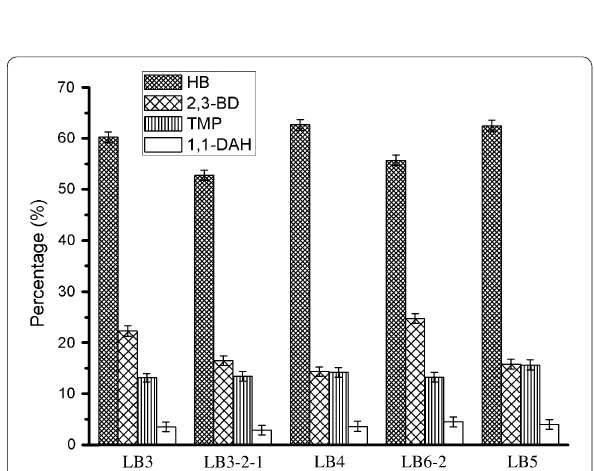
Fig. 6 The relative abundance of the five endophytes metabolites in the dichloromethane extraction site. Data were obtained after 72 h fermentation by GC/MS analysis. All samples were measured in triplicates; standard deviations were always found less than 10% in all